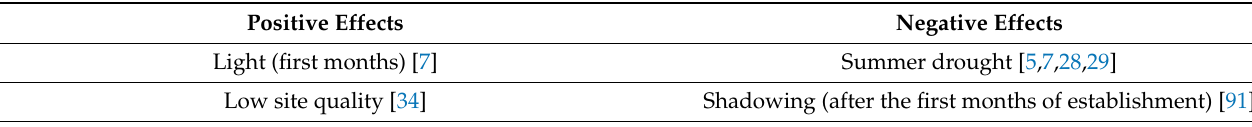
Table 3. Ecological factors influencing the natural regeneration of maritime pine. Phase: seedling